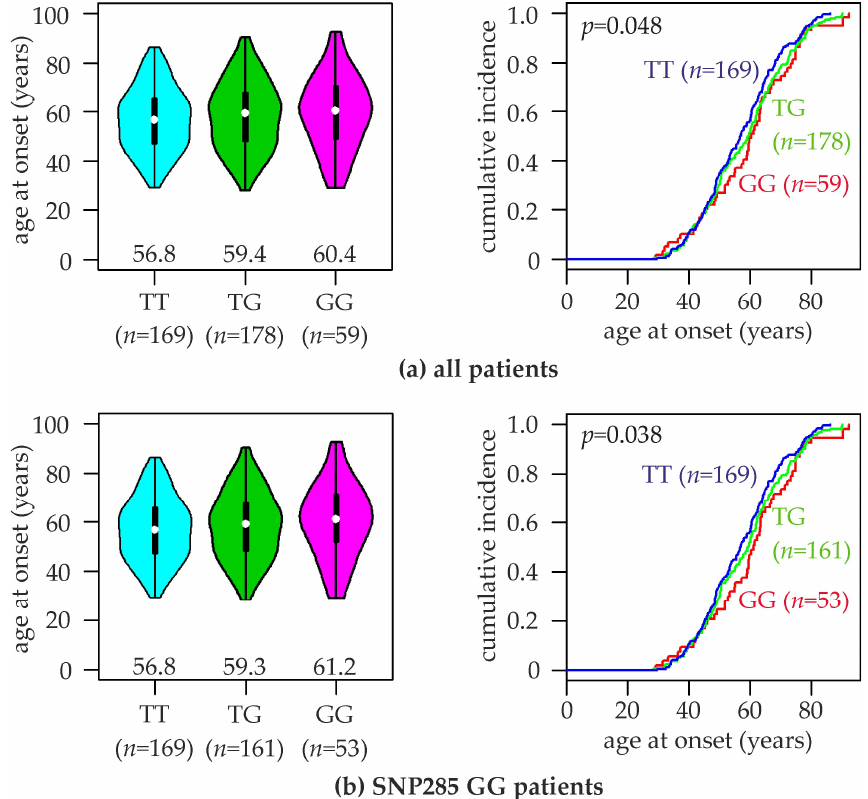
Figure 1. Association of SNP309 genotypes with the age at breast cancer onset. Violin plots (left) and curves of the cumulative breast cancer incidence (right) of the indicated age at onset are shown for ( a ) all patients of the study population, and ( b ) patients with the SNP285GG genotype. SNP309 genotypes (TT, TG, GG) and numbers of patients ( n ) are indicated. Numbers in left panels indicate the median age at breast cancer onset of each genotype (indicated by white dots).